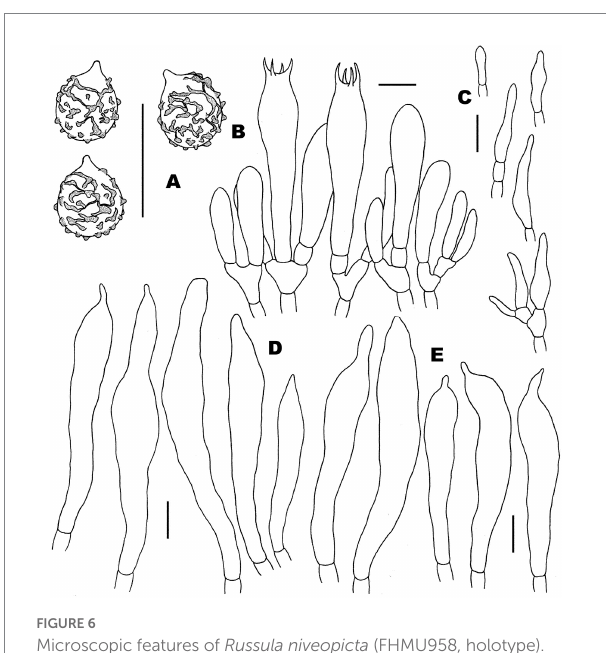
FIGURE 6 Microscopic features of Russula niveopicta (FHMU958, holotype). (A) Basidiospores. (B) Basidia and basidiola. (C) Marginal cells. (D) Pleurocystidia. (E) Cheilocystidia. Scale bars = 10 μ m. Drawings by Y. X. Han.